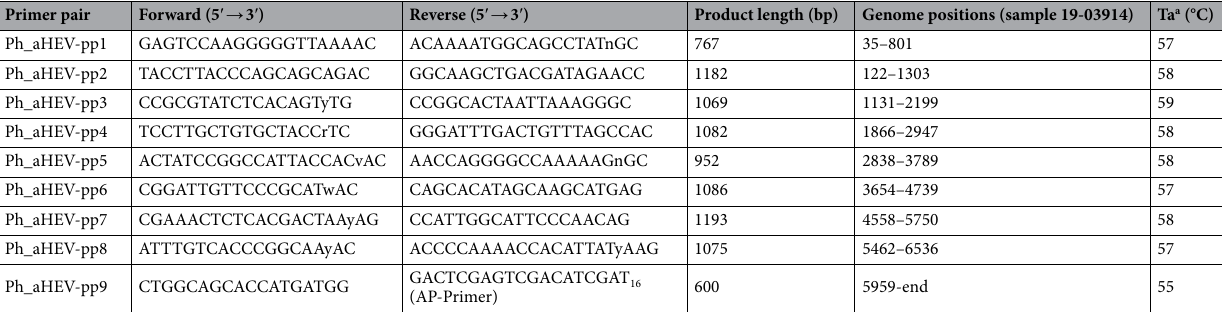
Table 2. List of primer pairs used to obtain the complete genome sequences of samples 19-13931-bile and 19-27337-bile, with respective product length and position regarding original sample 19-03914, and annealing temperature. a Annealing